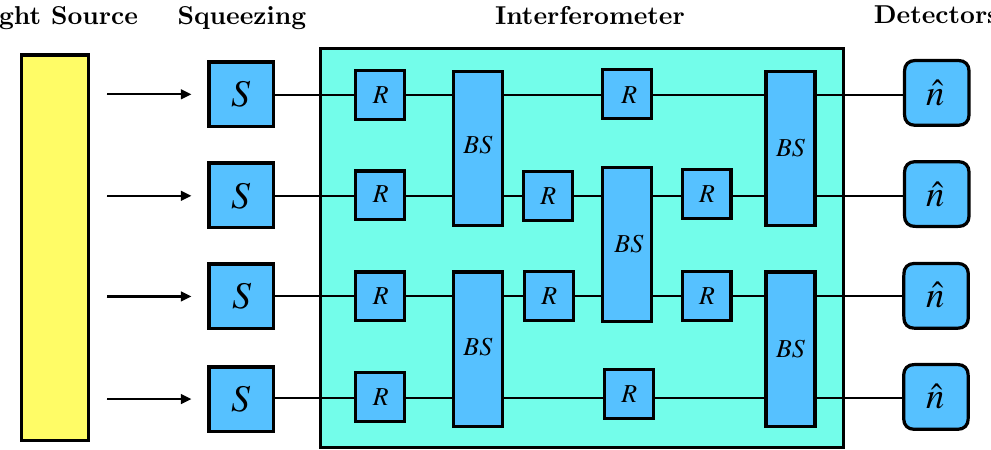
Figure 5. A Gaussian boson sampling device. It consists of a set of squeezing gates, an inter- ferometer and photon detectors. The interferometer itself is constructed from rotation gates and